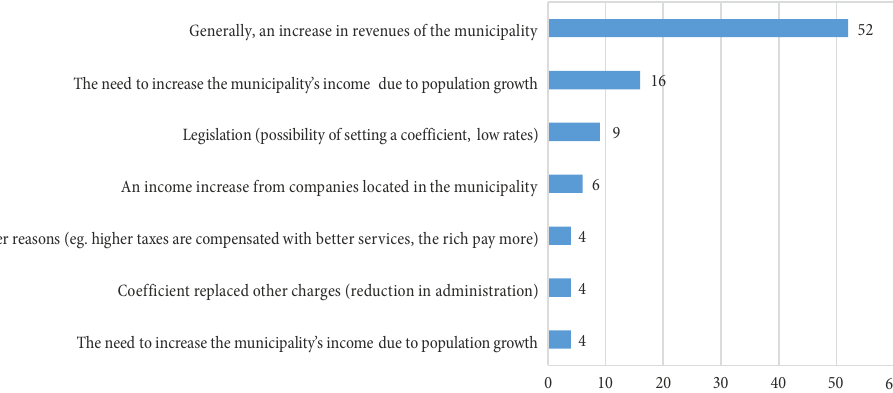
Fig. 6. Motivation for introduction of local